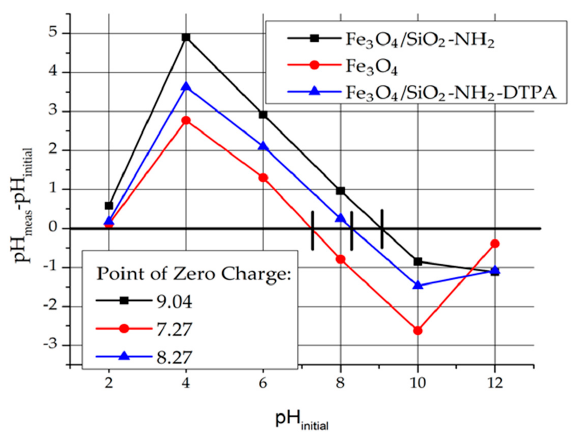
Figure 3. Surface charge of the core-shell particles of Fe 3 O 4 /SiO 2 -NH 2 and Fe 3 O 4 /SiO 2 -NH 2 -DTPA nanocomposites determined according to the pH drift method [31,32].